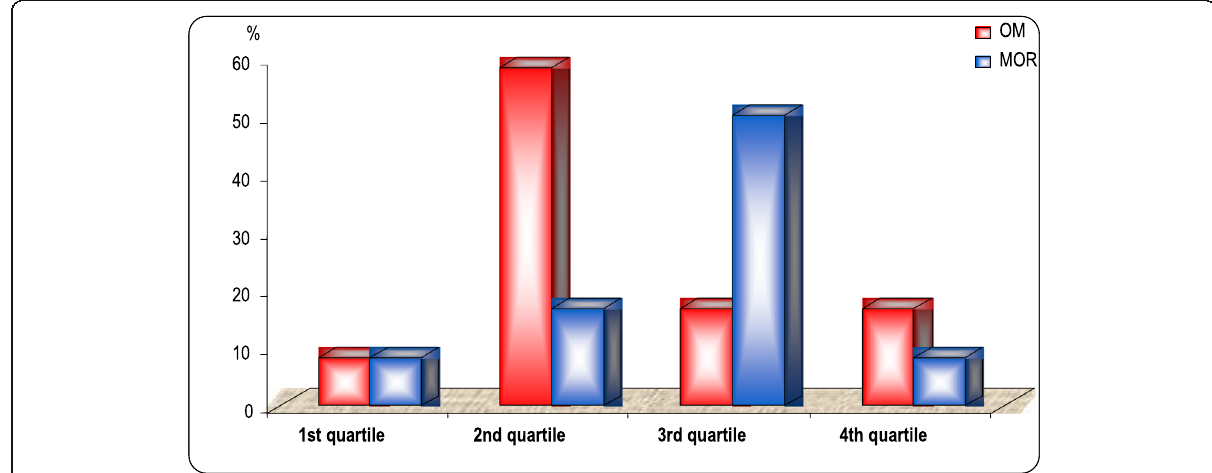
Fig. 1 Circadian variation of stroke onset 1 month before and during the month of